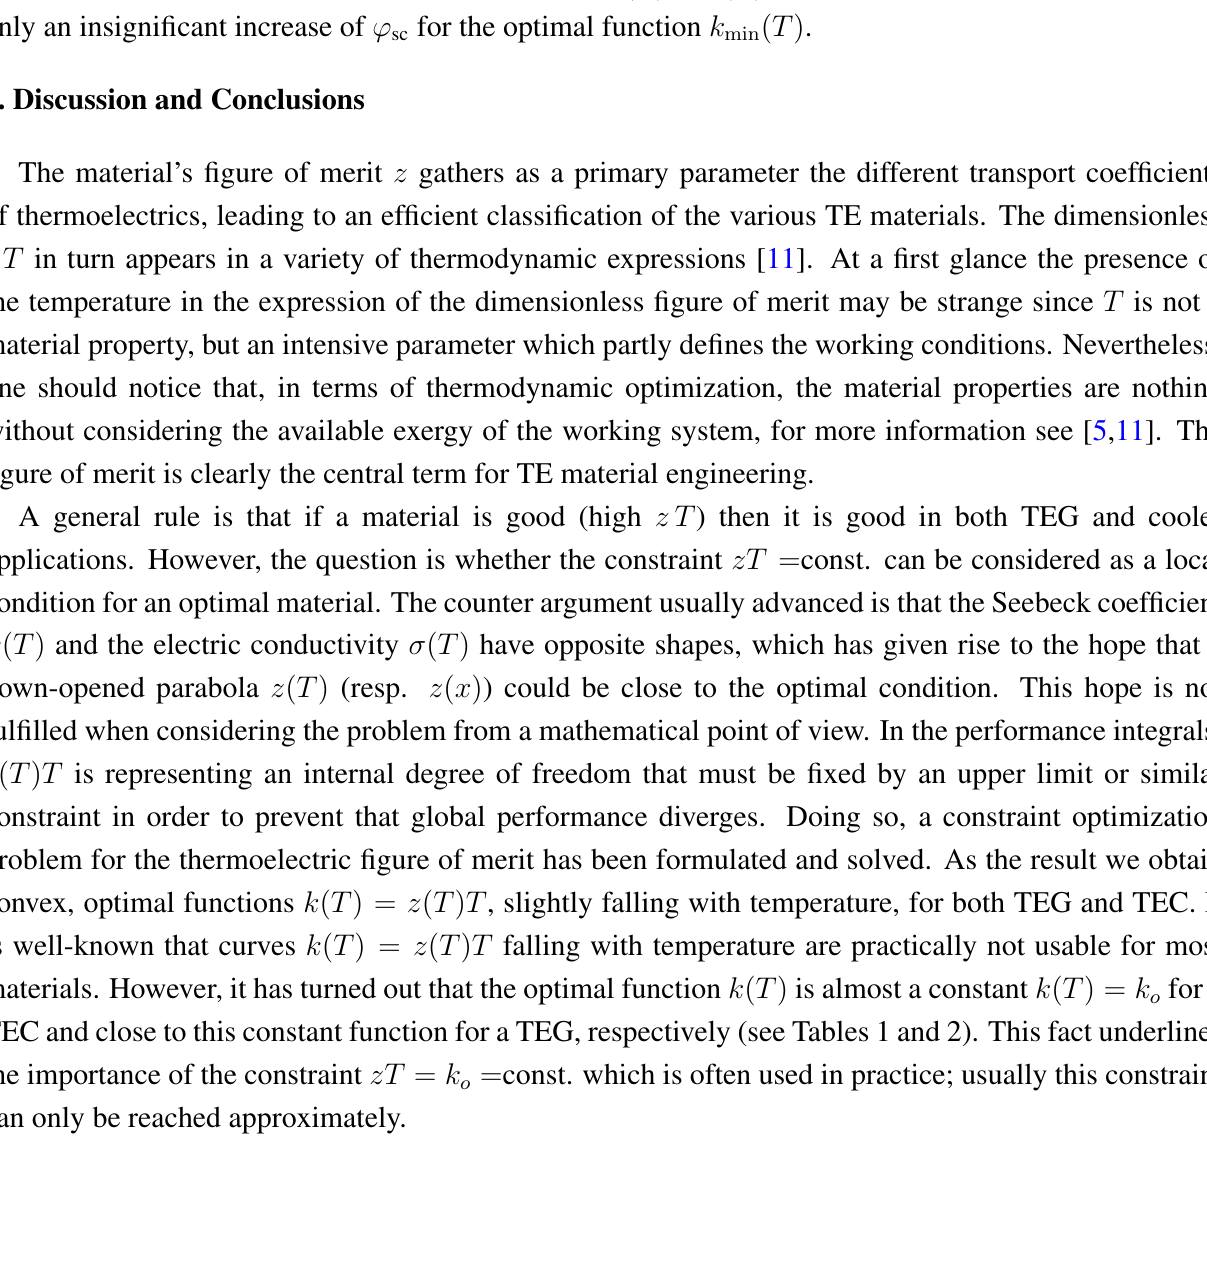
Table 2. Self-compatible coeff. of performance of a TEC with T